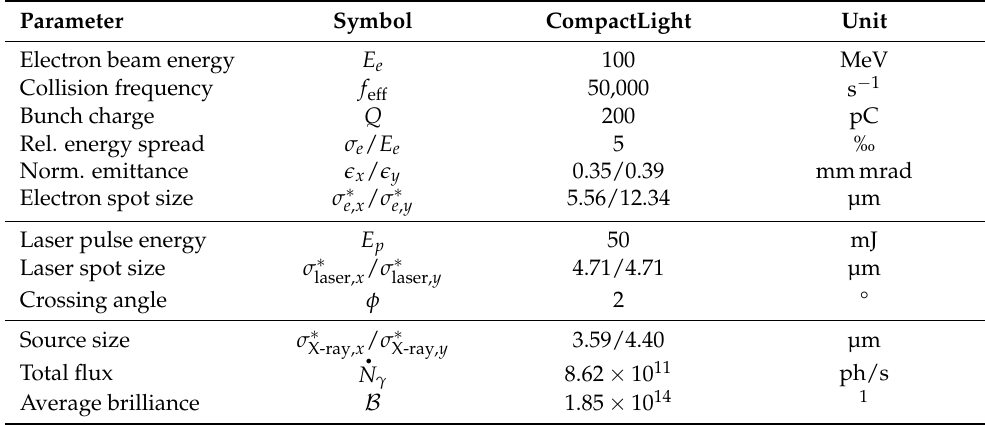
Table 8. The targeted source sizes can be reached from the final focus and FPC design. Table 8. Parameters of the CompactLight-based ICS source obtained for maximising flux in a 1.5mrad cone. All beam parameters were quoted at the